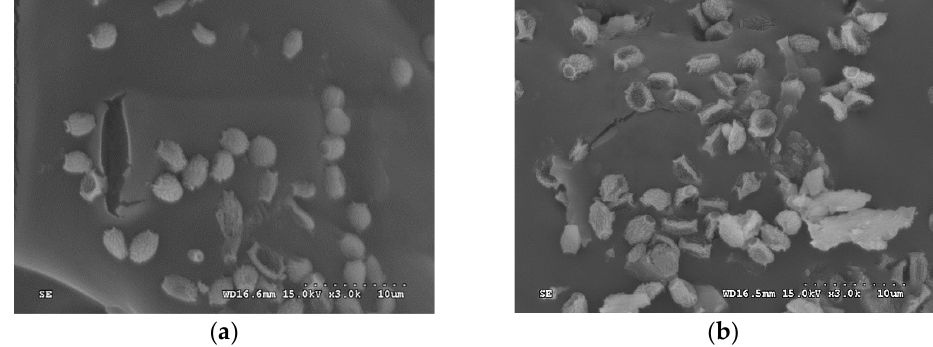
Figure 3. Scanning electron microscopy (SEM) images of inulin from ( a ) freeze-drying and ( b ) spray-drying.